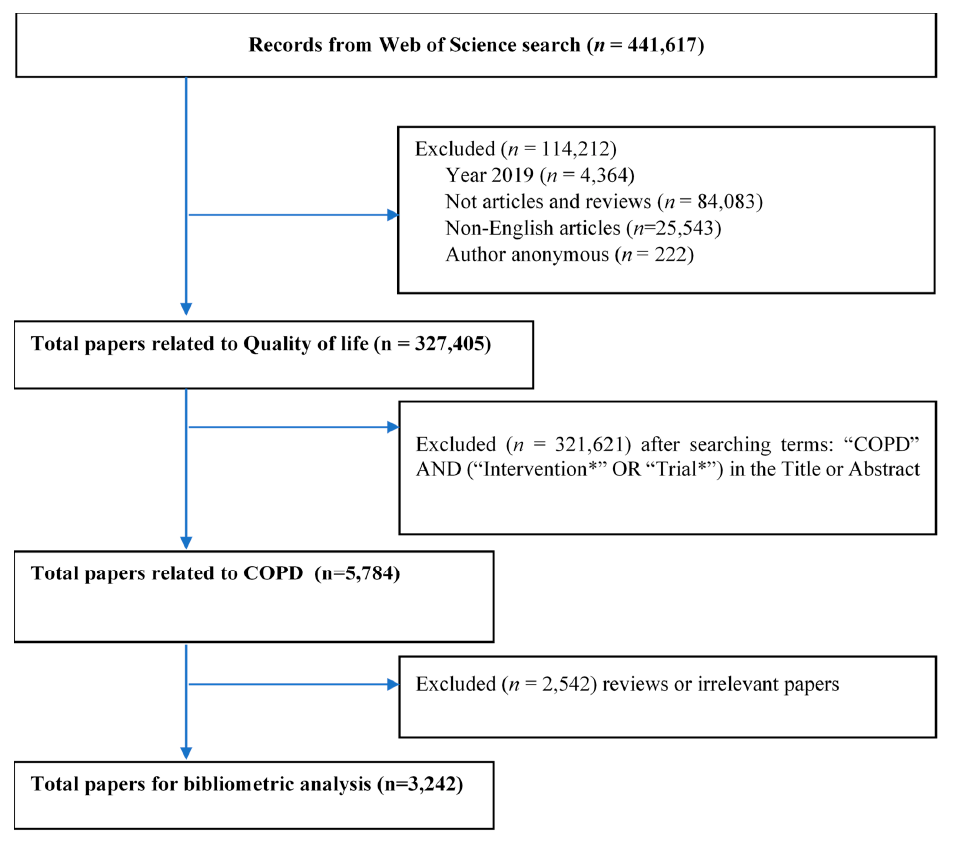
Figure A1. Selection of papers.